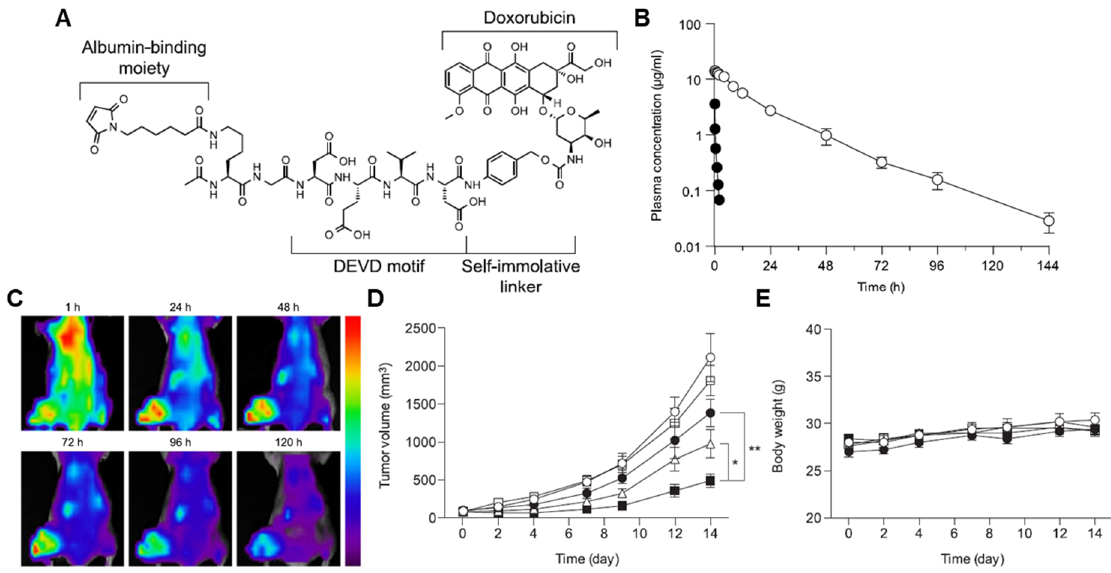
Figure 4. Caspase-3-specific albumin-binding prodrug. ( A ) Albumin-binding maleimide moiety is conjugated with doxorubicin through caspase-3-specific cleavable peptide KGDEVD and self-immolative linker (PABC), resulting in EMC-DEVD-S-DOX. ( B ) EMC-DEVD-S-DOX shows long half-life (~19 h). ( C ) EMC-DEVD-S-DOX efficiently accumulates within tumor tissues with detectable substances for 120 h. ( D , E ) EMC-DEVD-S-DOX significantly inhibits the tumor growth with minimal systemic toxicity. * p < 0.05 and ** p < 0.005. Reproduced with permission from [222]. Copyright 2016,